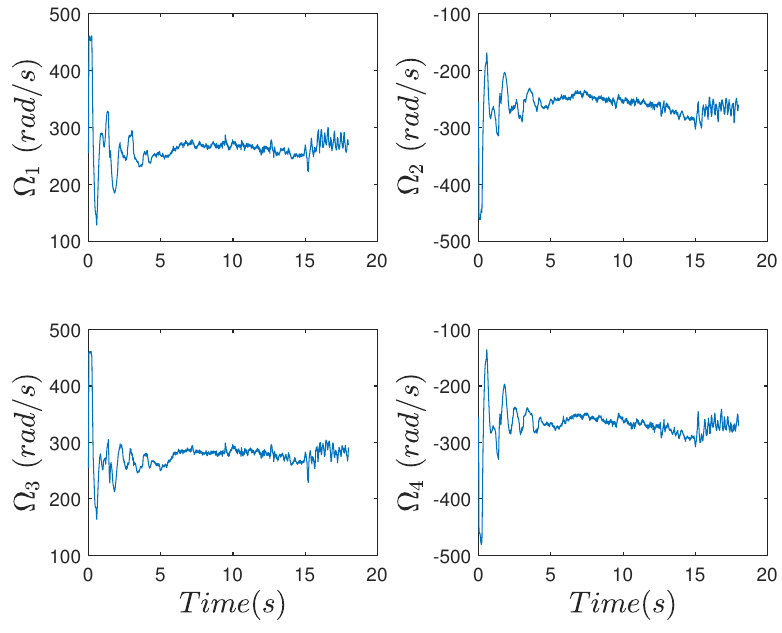
Figure 6. Hovering. Control inputs of the quadrotor MAV.